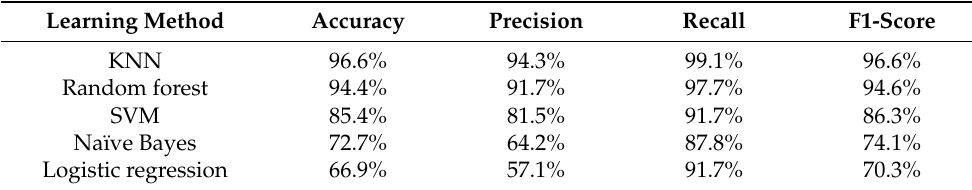
Table 5. Results of the classification performance of the models. Learning